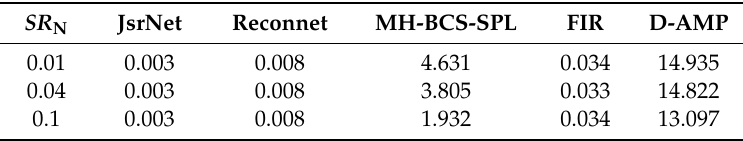
Table 2. Reconstruction speed comparisons (s).